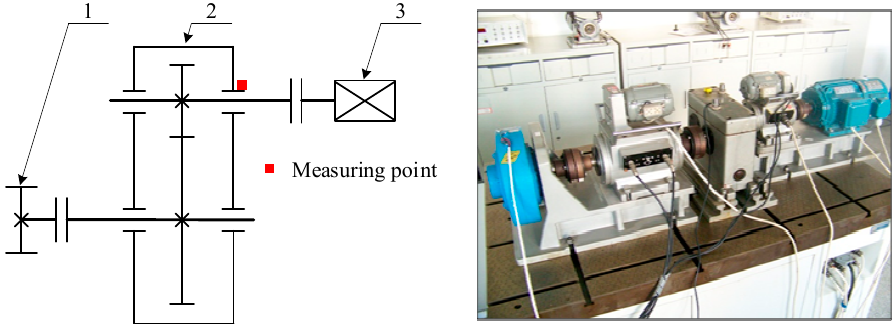
Figure 29. The schematic diagram and a picture of the experimental apparatus.